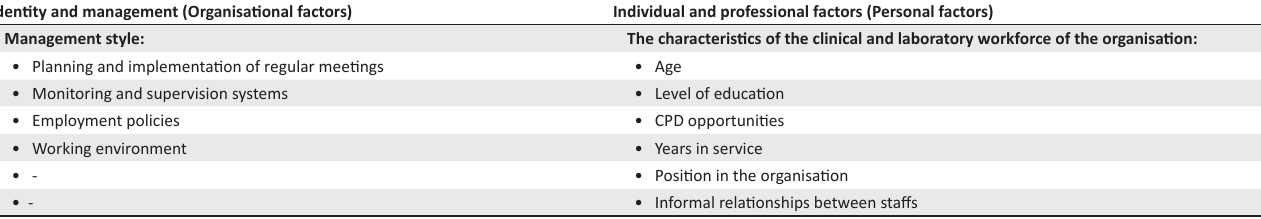
TABLE 1a: Analytical framework. This framework was developed to test our conceptual model, 16 and displays the organisational and personal factors playing a role during the three phases where clinicians and laboratory workers interact: pre-analytical, analytical and post-analytical. Identity and management (Organisational factors)